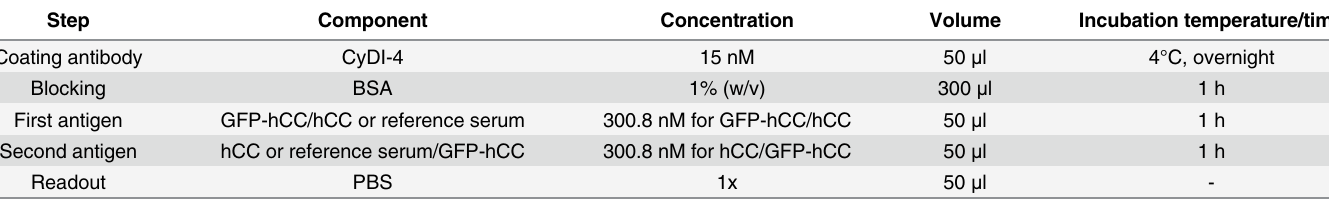
Table 1. Fluorescence-based replacement assay